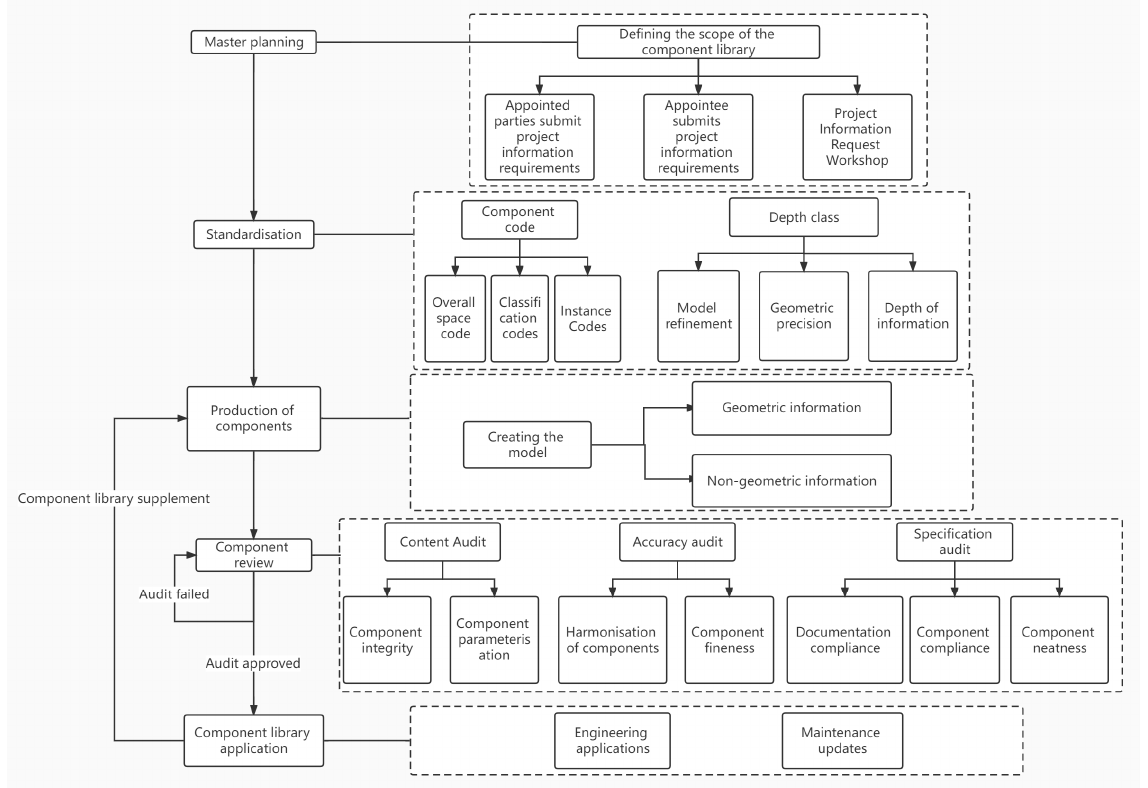
Figure 4. The process of creating interchange BIM libraries.